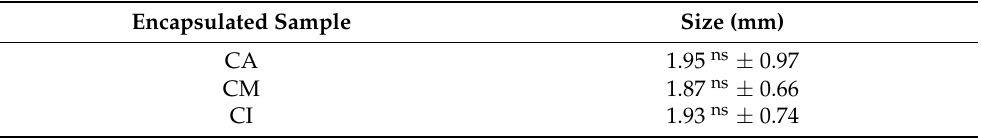
Table 2. Average bead size of alginate (CA), alginate/maltodextrin (CM), and alginate/inulin (CI) hydrogel